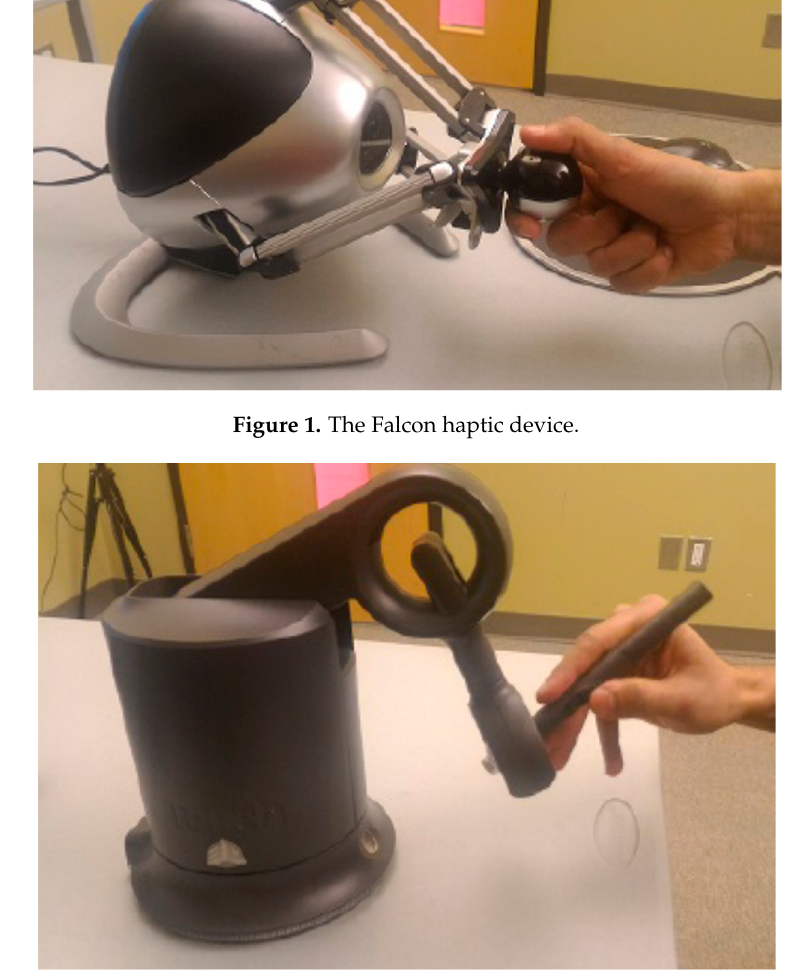
Figure 2. The Touch 3D Stylus haptic device.